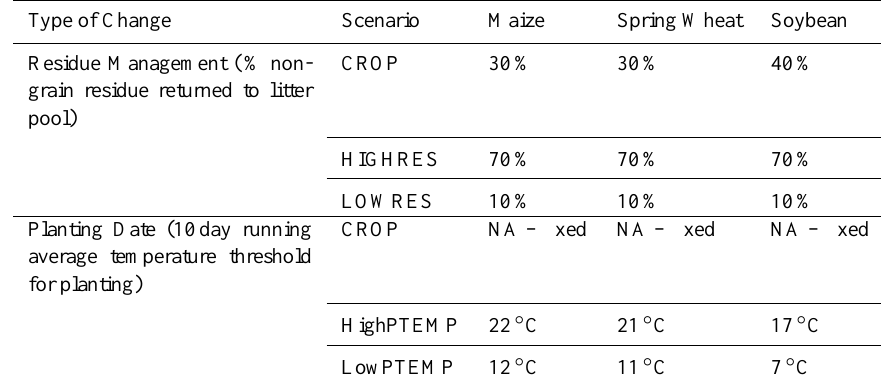
Table 3. Parameter values for the baseline CLM-Crop simulation and the case studies.